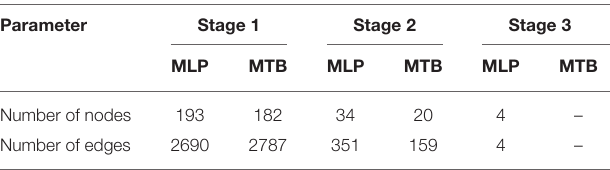
TABLE 4 | Number of proteins at each stage of the renormalization process for r B = 1 in the two mycobacteria. Parameter